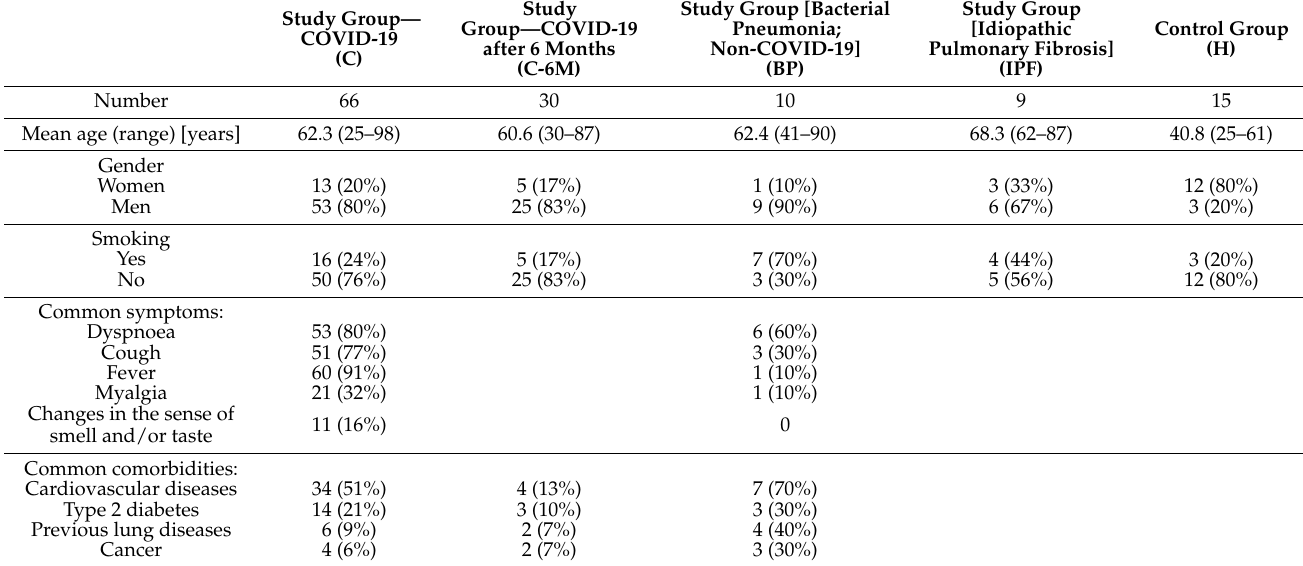
Table 1. Baseline demographic and disease